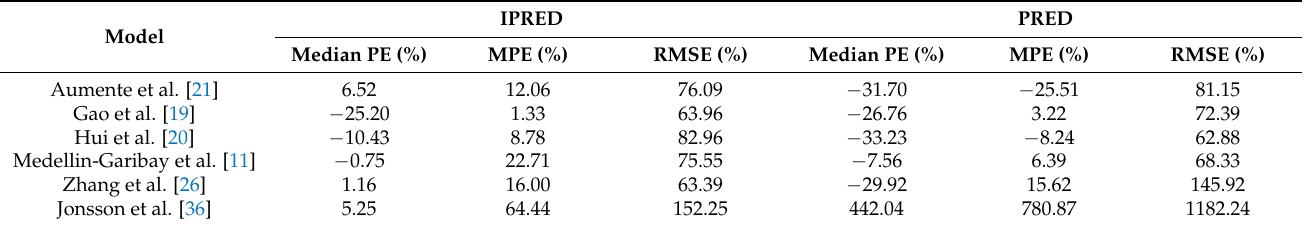
Figure 2. Observed concentrations versus population and individual predictions for the included population pharmacokinetic models of methotrexate in children with acute lymphoid leukemia. ( A ) Model proposed by Aumente et al. [21]; ( B ) model proposed by Gao et al. [19]; ( C ) model proposed by Hui et al. [20]; ( D ) model proposed by Medellin-Garibay et al. [11]; ( E ) model proposed by Zhang et al. [26]; and ( F ) model proposed by Jonsson et al. [36]. Table 3. Prediction error (PE) of the individual predictions (IPRED) and population predictions (PRED) to observations for the evaluated